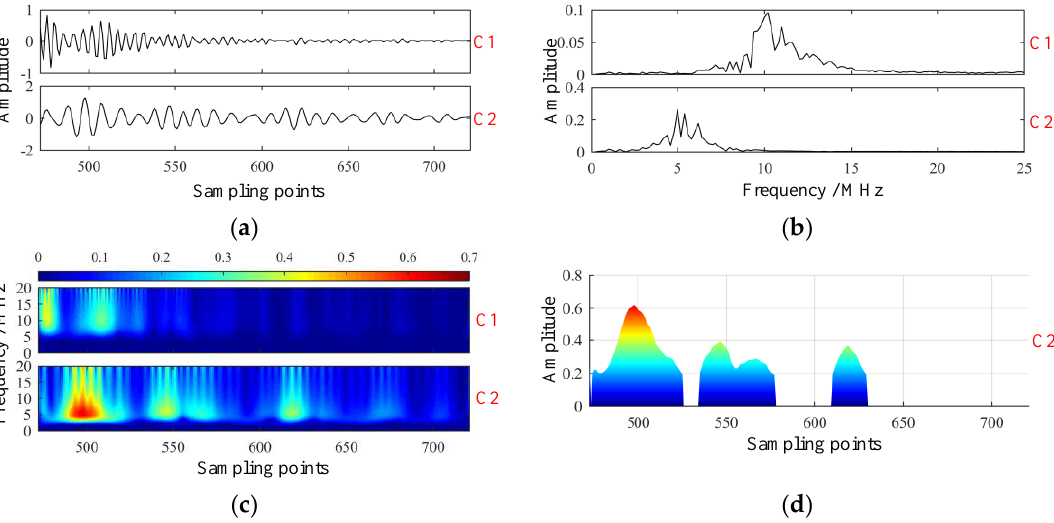
Figure 13. Modes extracted by VMD with parameters K = 2 and α = 16. ( a ) Intrinsic mode functions; ( b ) spectrums of intrinsic mode functions; ( c ) GST spectrums of intrinsic mode functions; and ( d ) projection of GST spectrum of C2.